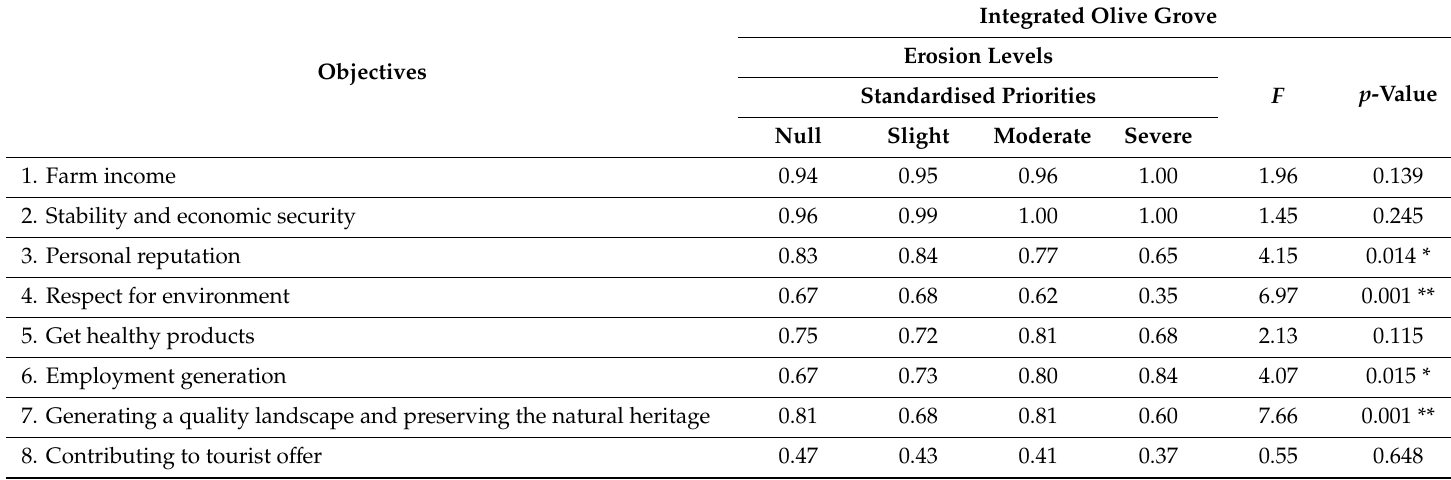
Table 5. Standardised priorities for the evaluated objectives of integrated olive groves in the Estepa region within its erosive levels. Statistical values of F (Kruskal–Wallis test) and p -values; significant ( < 0.05 *), very significant ( < 0.01 **), and highly significant ( < 0.001 ***) are